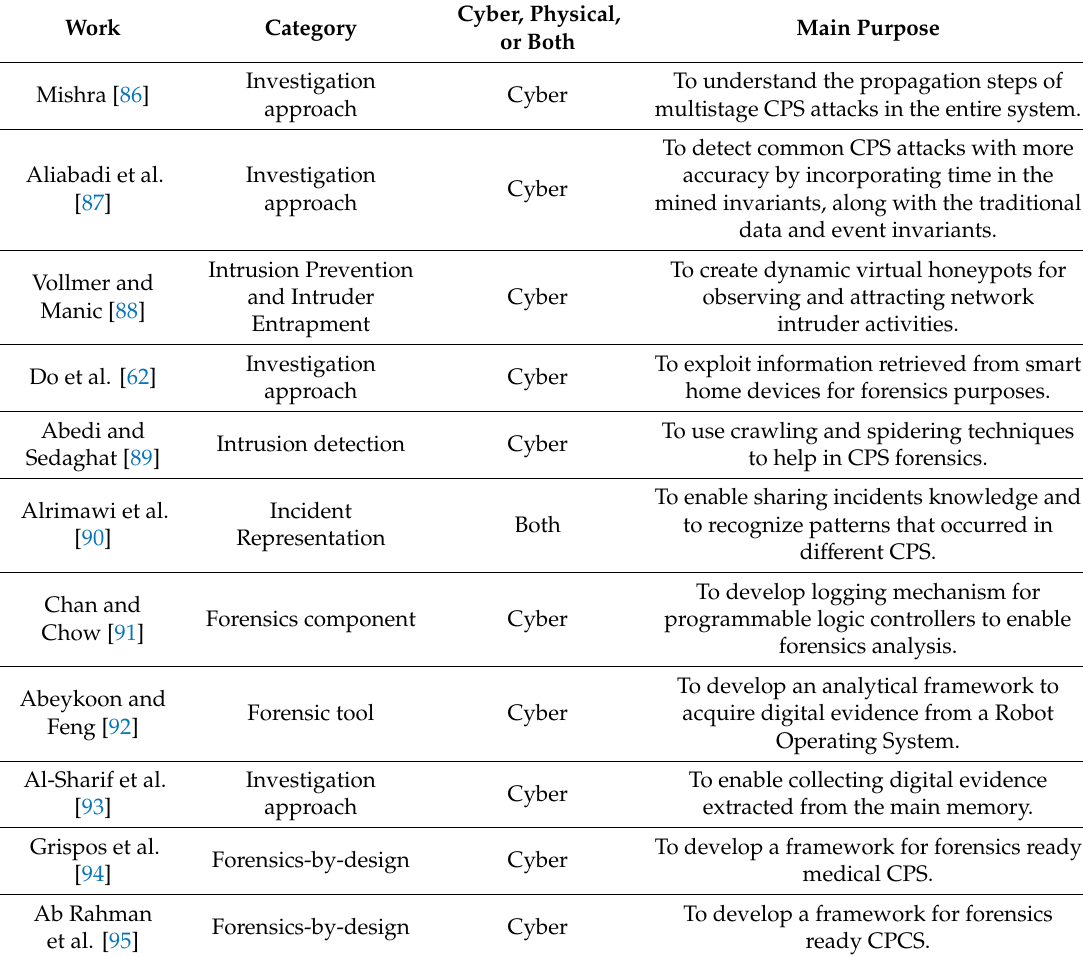
Table 3. A Summary of Current Research E ff orts for CPS